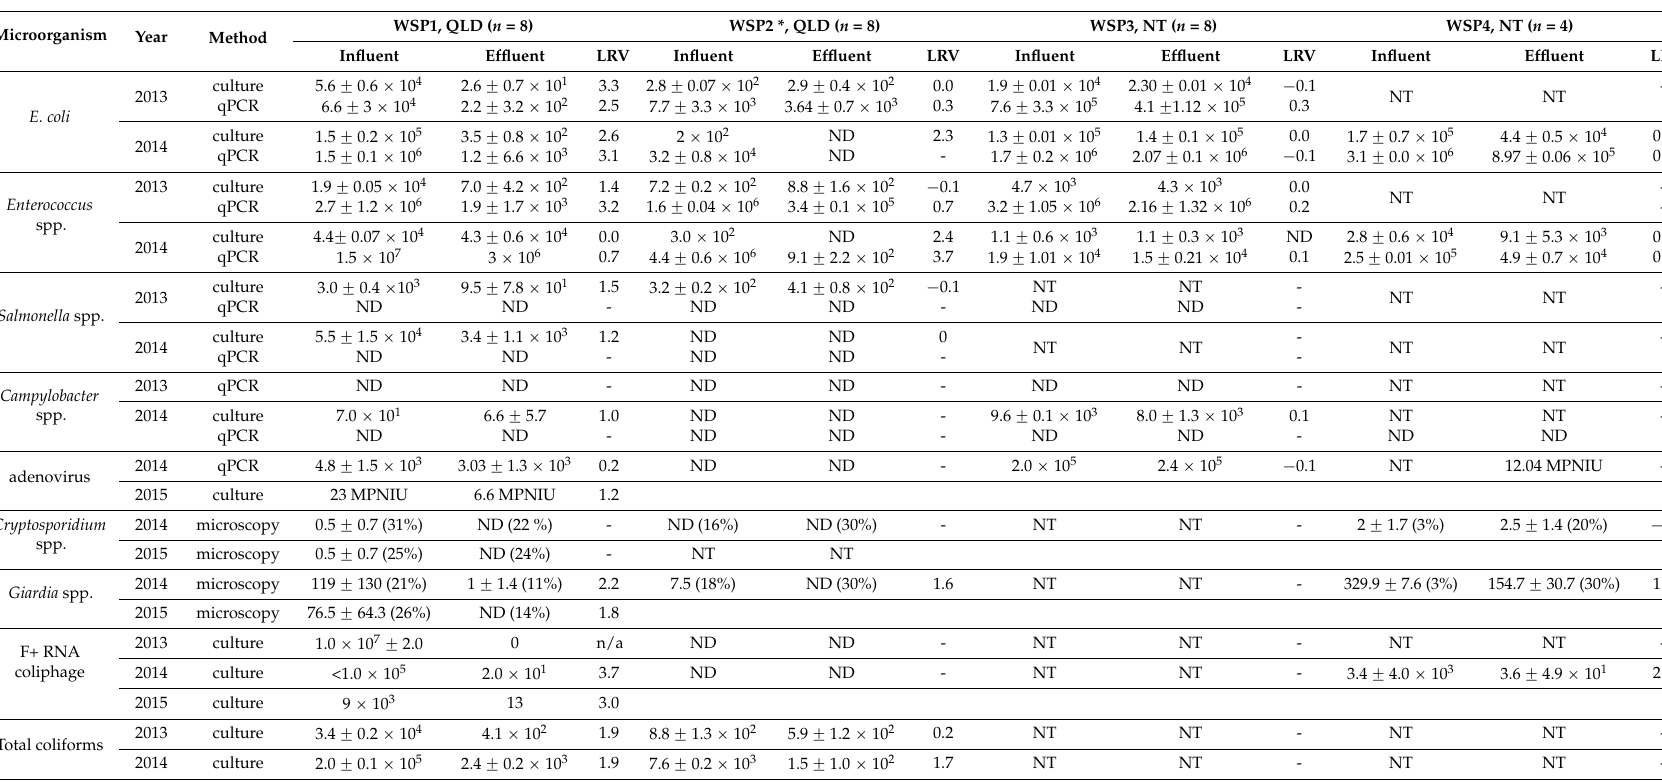
Table 3. Microbial concentrations and log removal values (LRV) in maturation ponds of four WSP systems tested over 2 years. Culture-based results are reported in CFU/PFU per 100 mL, qPCR counts are reported as genome copies per 100 mL. Microorganism